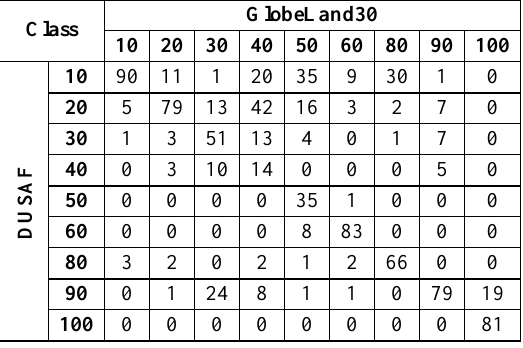
Table 4. Normalized confusion matrix [%]